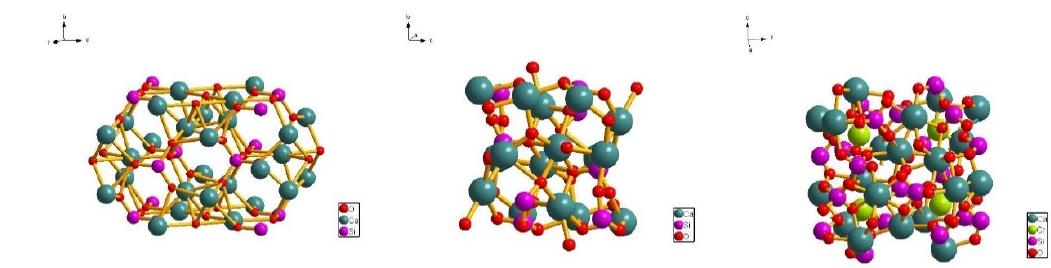
Figure 3. XRD patterns of clinker with varying Cr content.